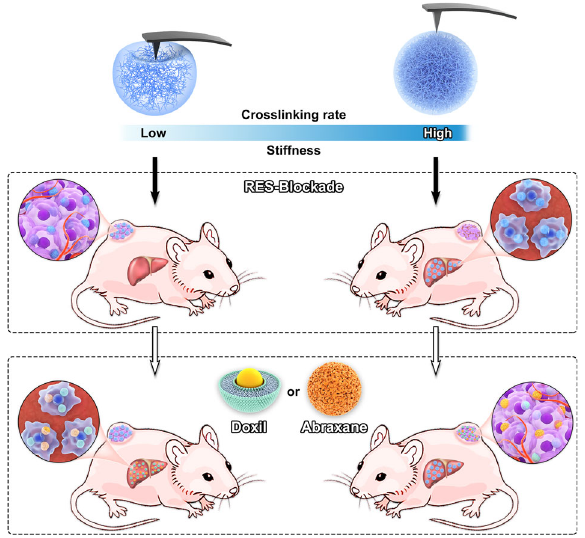
Fig. 1 | Schematic illustration of mechano-boosting nanomedicine antitumour ef fi cacy by blocking the reticuloendothelial system with stiff nanogels. Nano- gels with distinctive stiffness are injected preferentially and soft nanogels accu- mulate more in tumor, while stiff nanogels accumulate more in liver and temporarily block reticuloendothelial system (RES). Afterward, therapeutic nano- particles such as soft DOX-loaded nanogels, commercialized nanomedicine Doxil and Abraxane are injected and antitumour ef fi cacy is obviously promoted after RES-blockade by stiff